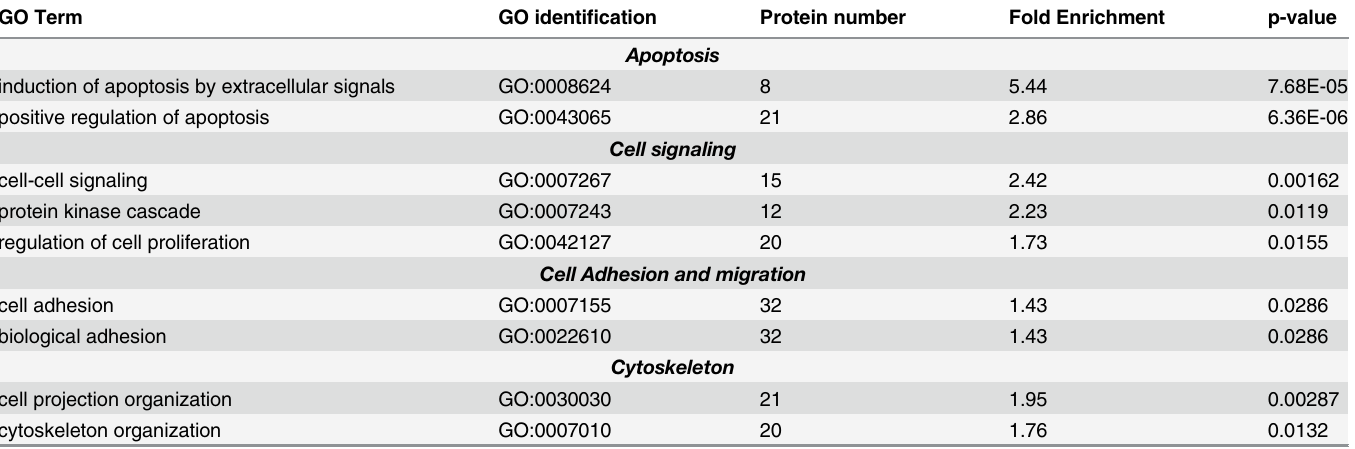
Table 1. Gene Ontology terms depleted from the cell surface upon A-769662 treatment.